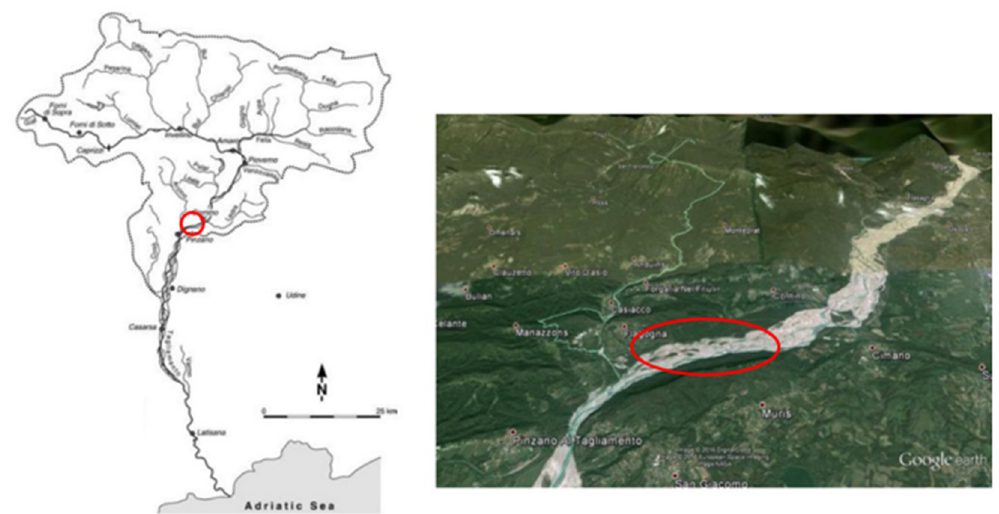
Figure 1. Localization of the study reach along the Tagliamento River (images obtained from Google Earth, Image ©2016 DigitalGlobe).